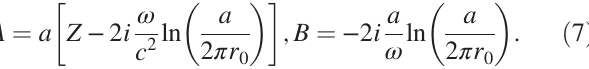
FIG. 1. Planar wire grid.